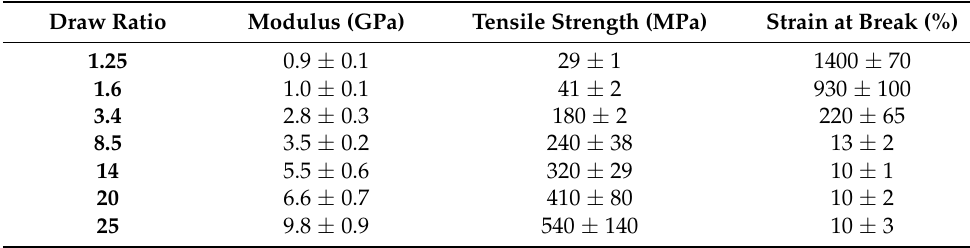
Figure 7. Typical stress–strain curves of oriented 50/50 PP/HDPE tapes at various draw ratios at room temperature. “X” indicates location of specimen fracture. Table 2. Summary of the mechanical properties of oriented 50/50 PP/HDPE tapes. The mean and standard deviation data are based on the average of five